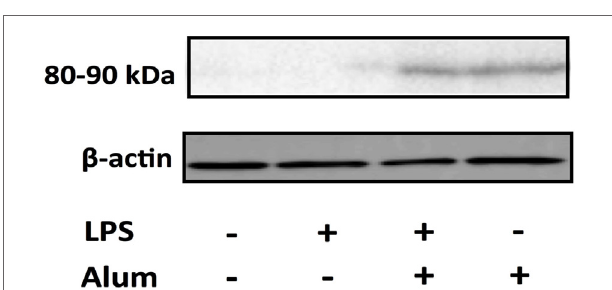
FigUre 6 | Alum promotes the oligomerization of ASC. Cells (10 × 10 6 ) were pretreated with LPS 3 h before alum was administered. Cell lysates were harvested 3 h later and ASC oligomers (80–90 kDa) were detected through western blotting. The data are representative of two animals aged < 6 months old.